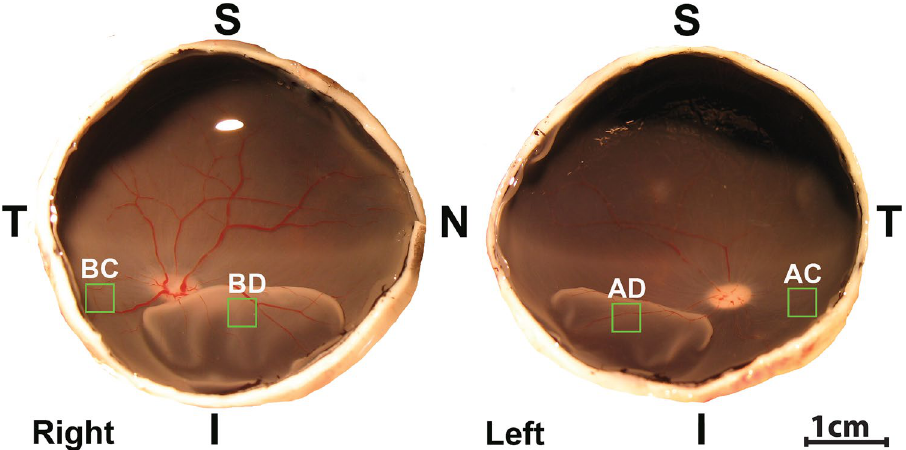
Figure 1. Eyecups from a right and left eye illustrating retinal detachments in the nasal-inferior quadrants. Location of retinal samples (green box) taken from BSS-treated eye attached (BC) and detached area (BD) and from the AR13503-treated eye corresponding attached (AC) and detached areas (AD). S superior, T temporal, I inferior, N